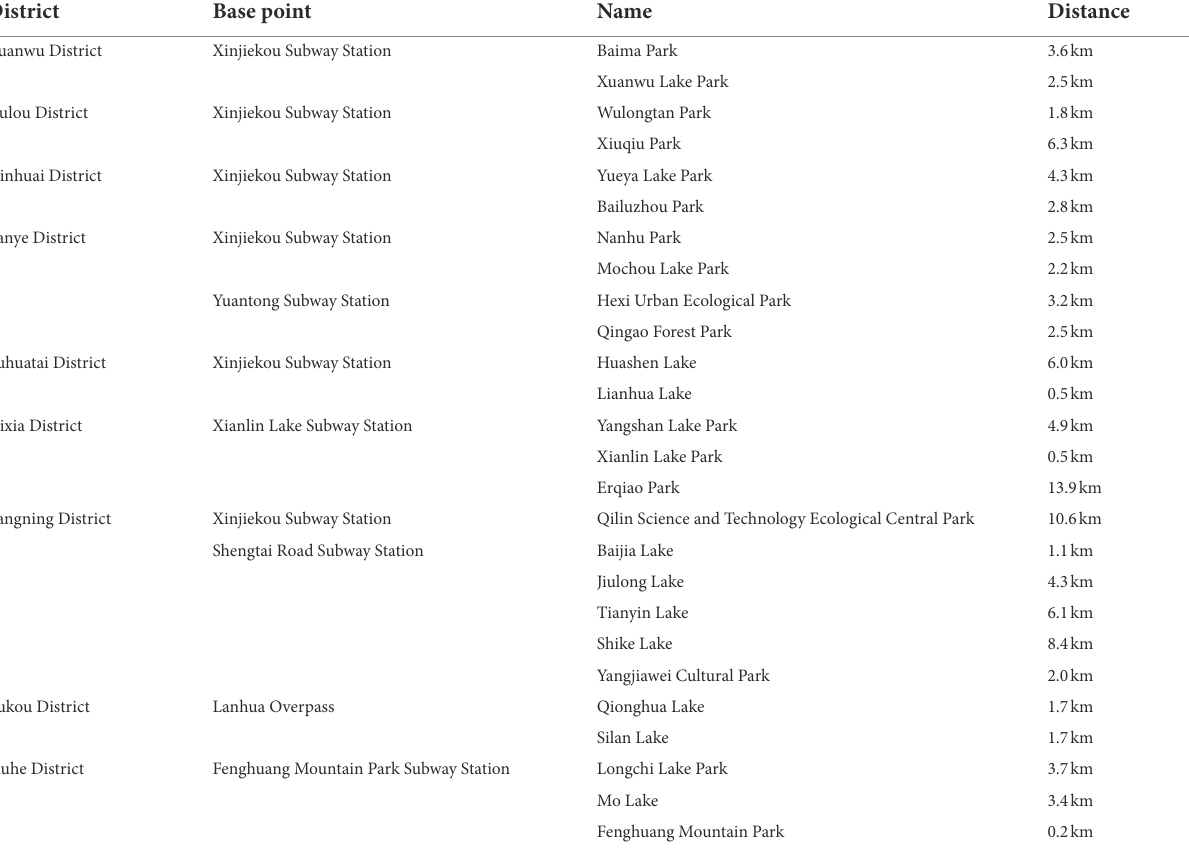
TABLE 10 The distance between the water body of the urban green space and the center of the region. District Base point Name